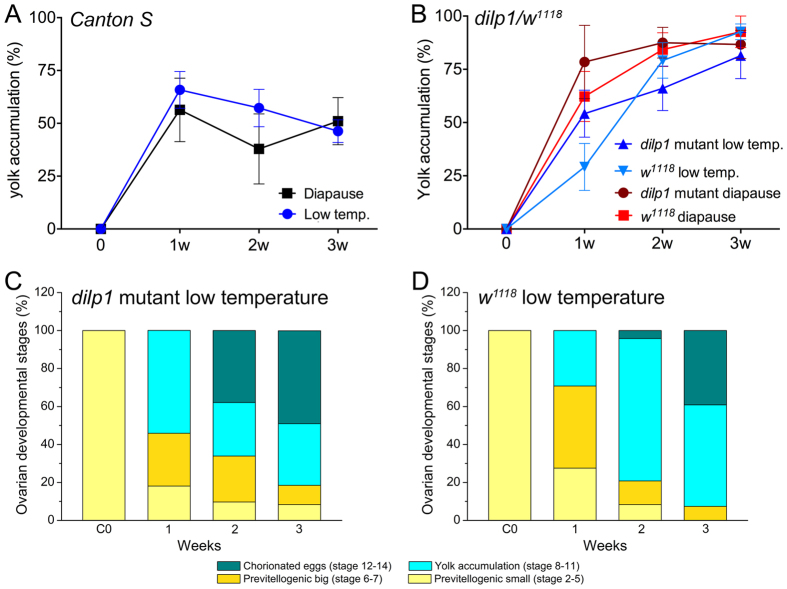
Diapause incidence is not affected in dilp1 mutant flies.(A) Exposure to 11 °C with 12L:12D (Low temp) and diapause conditions induce similar effects on yolk accumulation in Canton S flies over three weeks and suggest that after 3wD about 50% of the flies have entered diapause. (B) In dilp1 mutant flies exposed to the same conditions the effect on yolk accumulation is less strong over 3 weeks than Canton S and does not differ significantly from control flies (w1118). Data are shown as means ± S.E.M, n = 7–14 flies from 4 independent replicates (ns – not significant, as assessed by two way ANOVA with Bonferroni’s multiple comparisons tests). Note that w1118 flies are much less prone to diapause than Canton S28. (C,D) Graphical representation of ovarian development showing defined stages of egg differentiation.